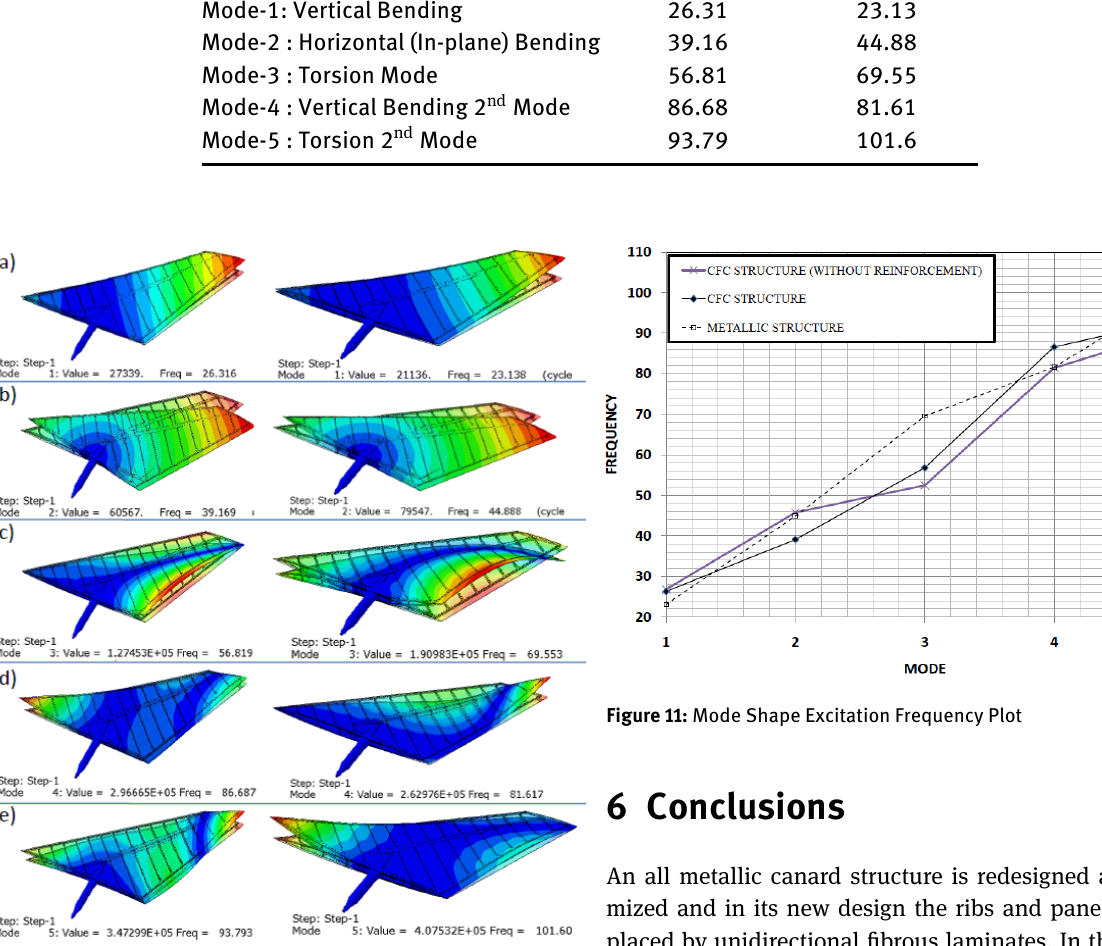
Figure 10: Mode Shapes CFC and Metallic Structure: (a) Mode 1, (b) Mode 2, (c) Mode 3, (d) Mode 4 and (e) Mode 5